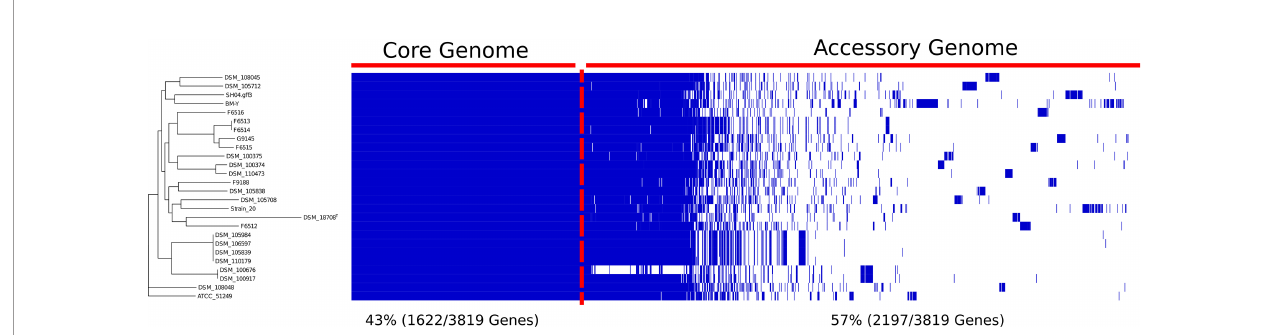
FIGURE 1 | Linearized visualization of W. chitiniclastica pan-genome along with the phylogenetic tree. The pangenome was visualized based on the software Phandango (Had fi eld et al., 2018).